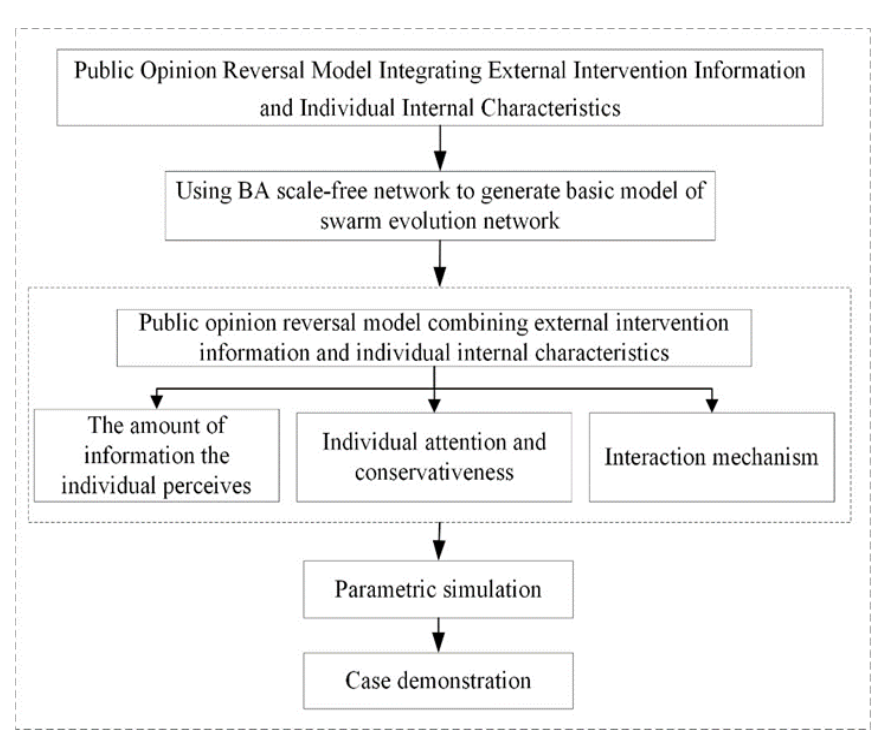
Figure 1. Study framework.